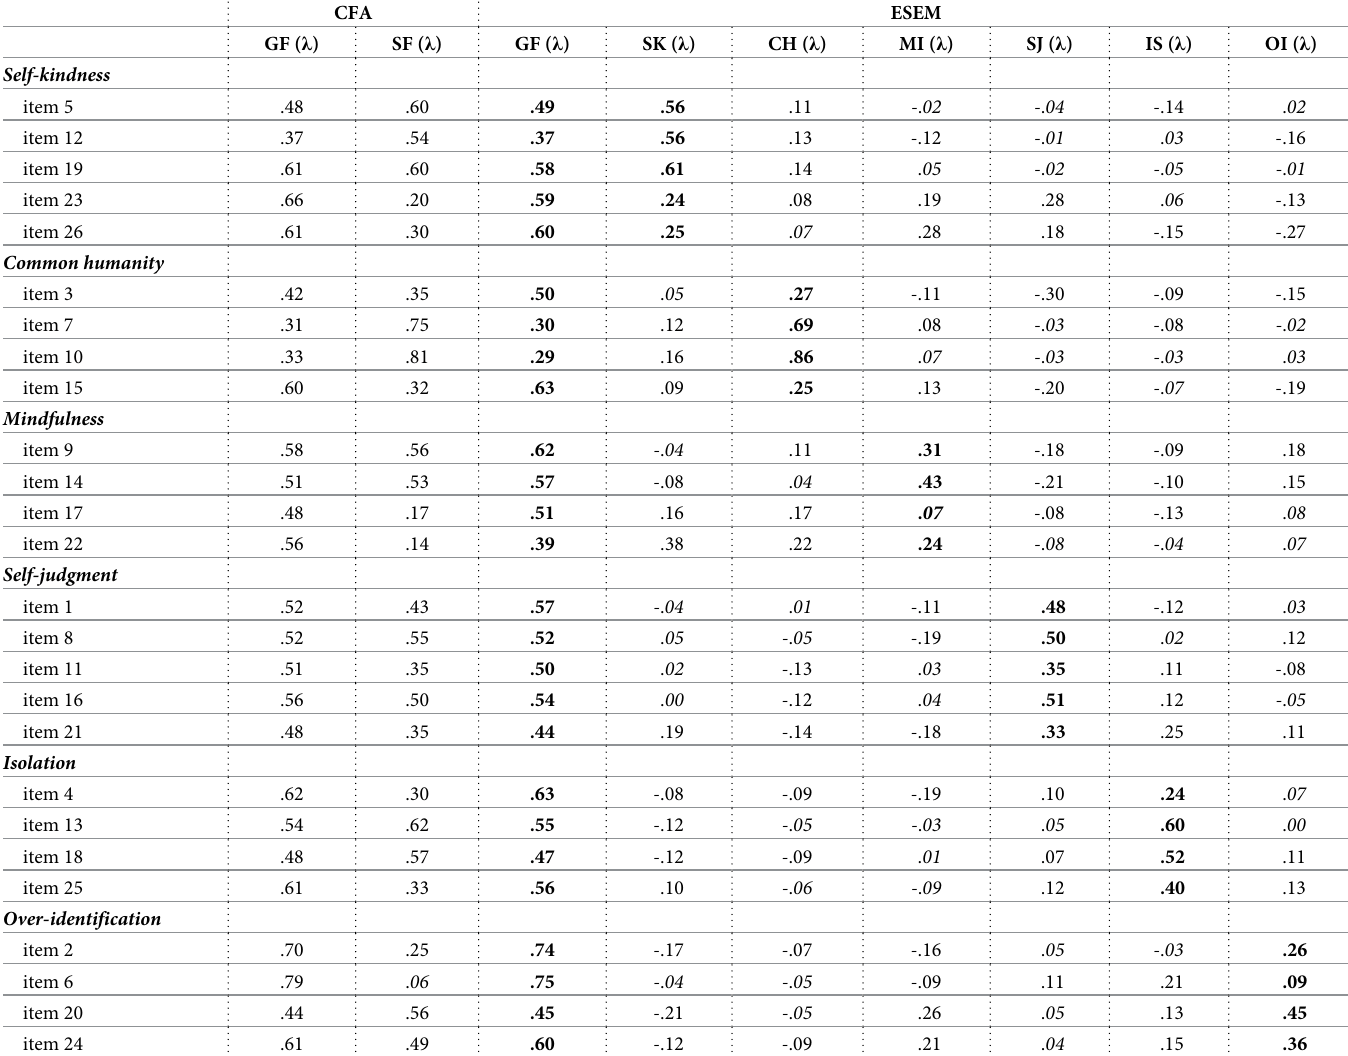
Table 3. Standardised factor loadings for single-bifactor model: CFA and ESEM